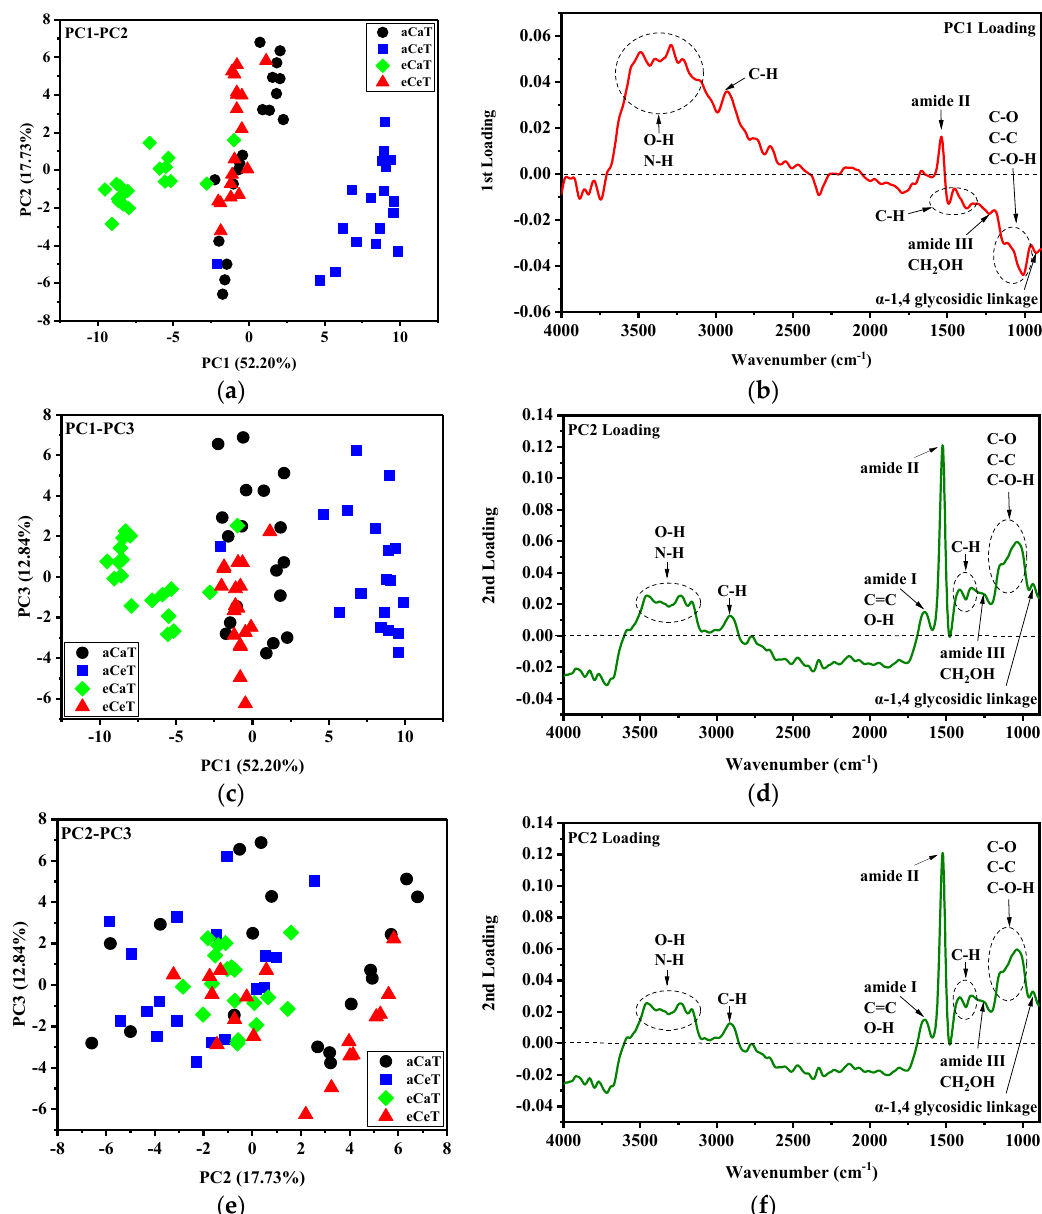
Figure 5. Principal component score distributions ( a – c ) and principal component loading plots ( d – f ) of the first three principal components from the FTIR-PAS spectra of the rice in the range of 900–4000 cm − 1 . Note: aCaT, aCeT, eCaT, and eCeT refer to ambient conditions, increased temperature, elevated CO 2 , and the combination of elevated CO 2 and increased temperature,